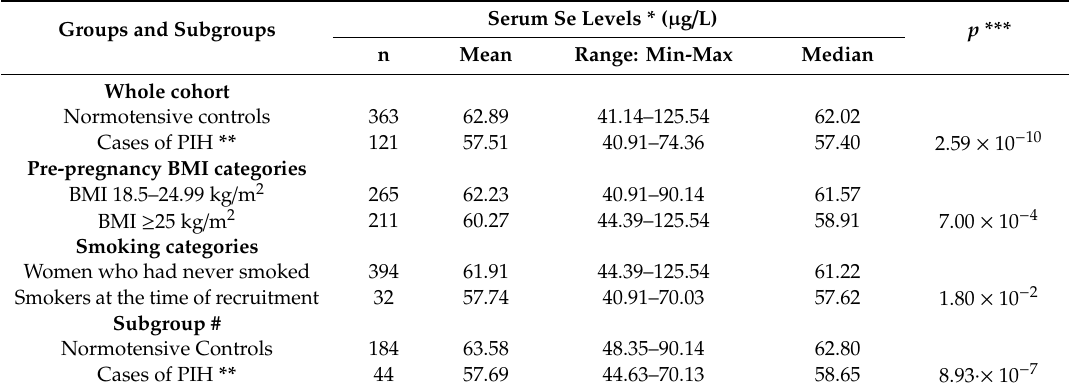
Table 2. Serum Se levels (in the 10–14th gestational week) in the groups and subgroups.